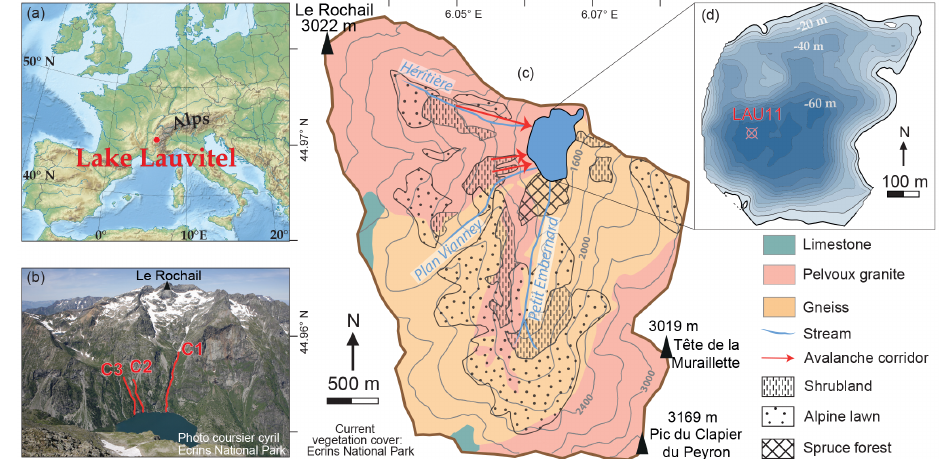
Figure 1. (a) Location of Lake Lauvitel in the western Alps. (b) Photograph towards the west of the lake watershed exhibiting three avalanche corridors. (c) Simplified geological maps of Lake Lauvitel watershed and current vegetation cover. (d) Lake bathymetry and position of LAU11 sediment core.